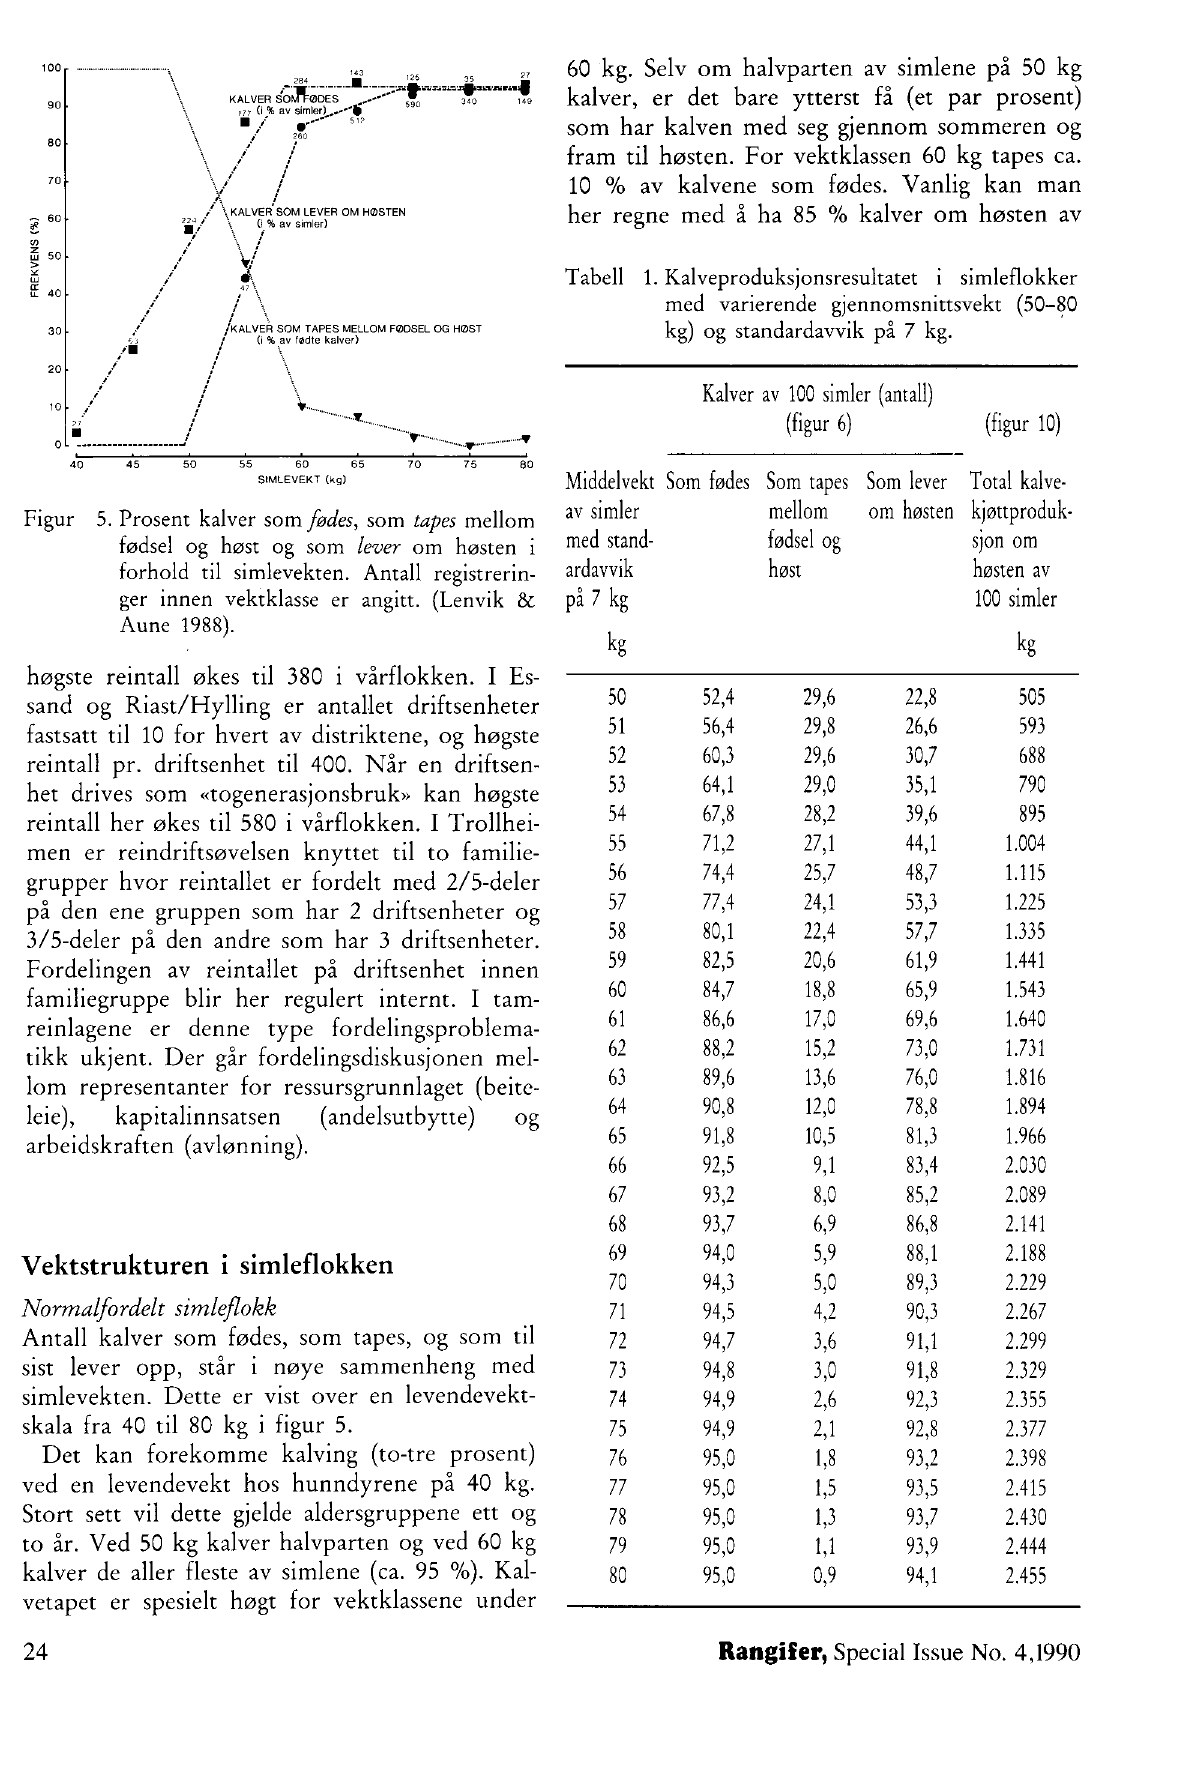
Tabell 1. Kalveproduksjonsresultatet i simleflokker med varierende gjennomsnittsvekt